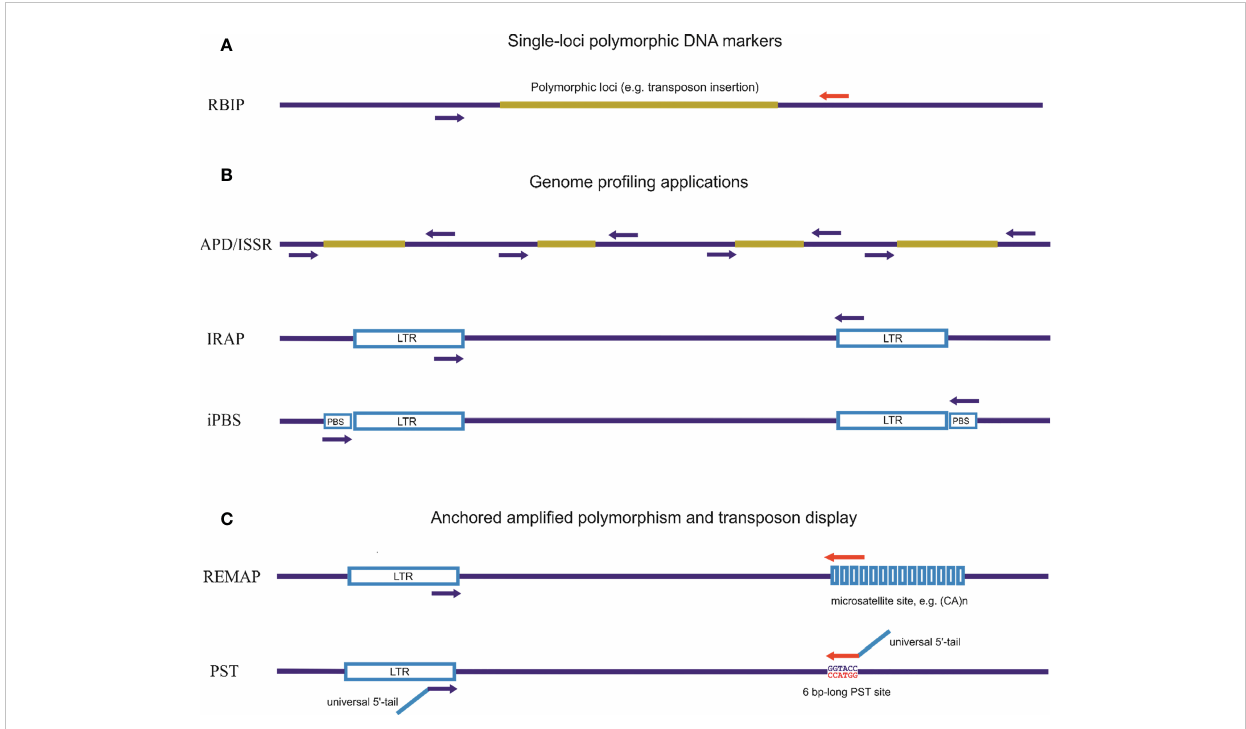
FIGURE 2 Different approaches for detecting inter-retrotransposon ampli fi ed polymorphisms using PCR techniques. (A) . Single-loci polymorphic DNA markers. Retrotransposon-Based Insertional Polymorphism (RBIP) is a codominant marker system that uses PCR primers designed for fl anking retrotransposon DNA to study insertional polymorphisms in individual retrotransposons. This method detects the presence of mobile element insertions or differences in tandem repeats based on PCR product length. (B) . PCR-based genome pro fi ling applications. Random ampli fi cation of polymorphic DNA (RAPD) is based on the use of a single primer (short or standard length) for ampli fi cation. Inter-simple sequence repeat (ISSR) is a PCR method for DNA fi ngerprinting using a single primer complementary to the microsatellite sequence. Inter-Repeat Ampli fi ed Polymorphism (IRAP) is a PCR method for DNA fi ngerprinting based on using a single repeat-speci fi c primer. Inter-Primer Binding Site (iPBS) is a PCR method for DNA fi ngerprinting based on the actually universal occurrence of complement tRNA as a binding site for the reverse transcriptase site in LTR retrotransposons. (C) . Anchored genome pro fi ling and transposon display applications using one speci fi c primer for repeat elements in combination with an anchored non-speci fi c primer. Retrotransposon Microsatellite Ampli fi ed Polymorphism (REMAP) is a PCR method for DNA fi ngerprinting where one of the two primers matches a microsatellite motif with second primers associated with retrotransposons (or any type of repeat sequence). Palindromic Sequence-Targeted (PST) and Transposon Display (TD) are PCR-based methods that combine repeat-speci fi c primers with a universal primer able to anneal to palindromic sequences. PST-PCR involves two rounds of PCR. The fi rst round utilizes a combination of one sequence-speci fi c primer and one universal primer (PST). The second round involves a combination of single- or two-tailed primers; one anneals to a 5 ′ -tail attached to the sequence-speci fi c primer and the